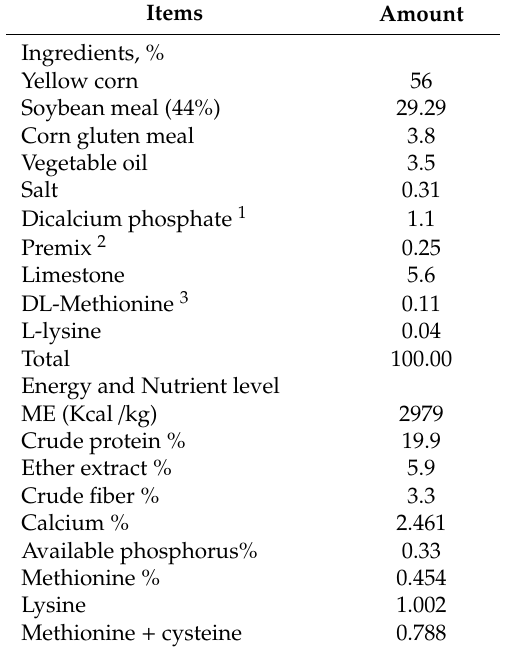
Table 2. Composition and nutrient level of the basal diet on a dry matter basis.